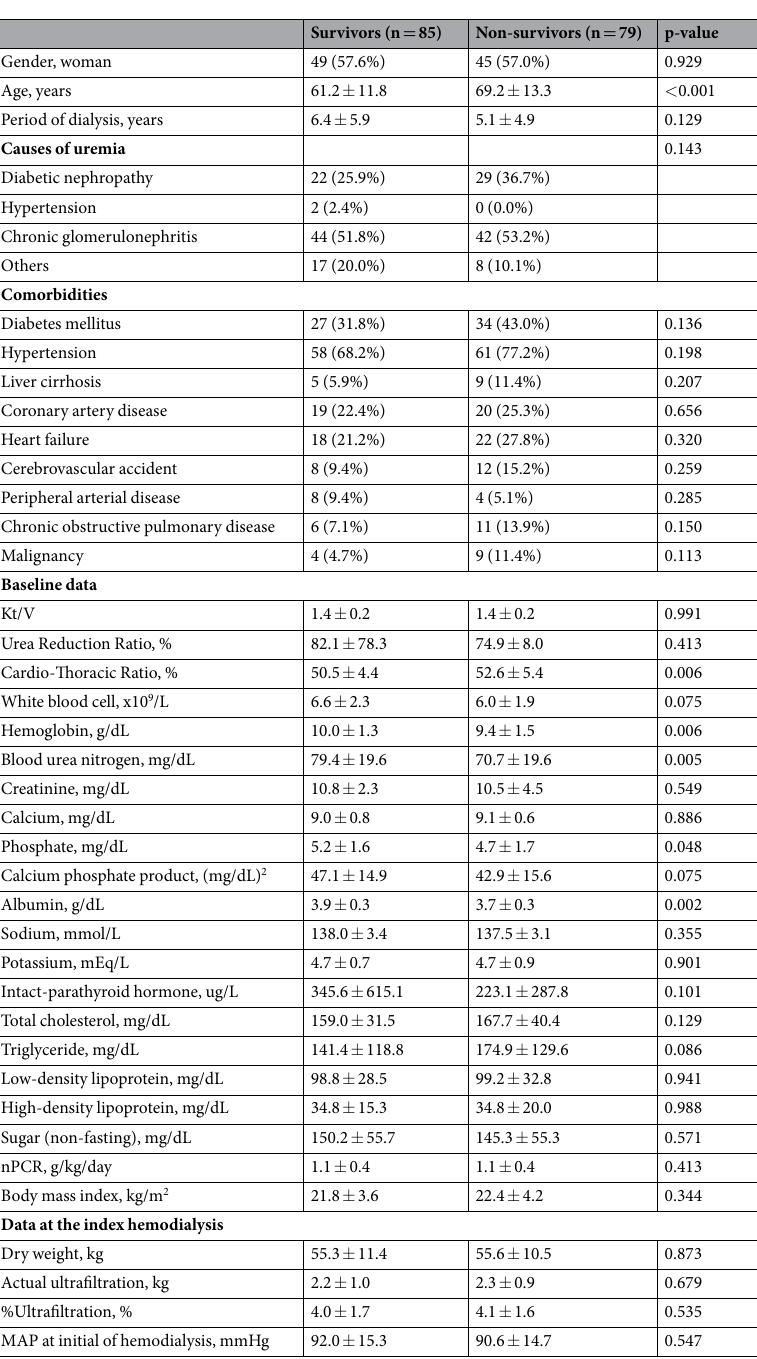
Table 1. Comparisons of the baseline characteristics and clinical variables between survivors and non- survivors at 8-year follow-up. Notes: Values are presented as the mean ± standard deviation for continuous variables or number (%) for categorical variables unless otherwise stated. P-value was calculated using a Chi- square test or independent student’s t -test as appropriate. Baseline laboratory data were the pre-dialysis data obtained when patients are receiving HRV measurements. Abbreviations: i-PTH, intact-parathyroid hormone; MAP, mean arterial pressure; nPCR, normalized protein catabolic